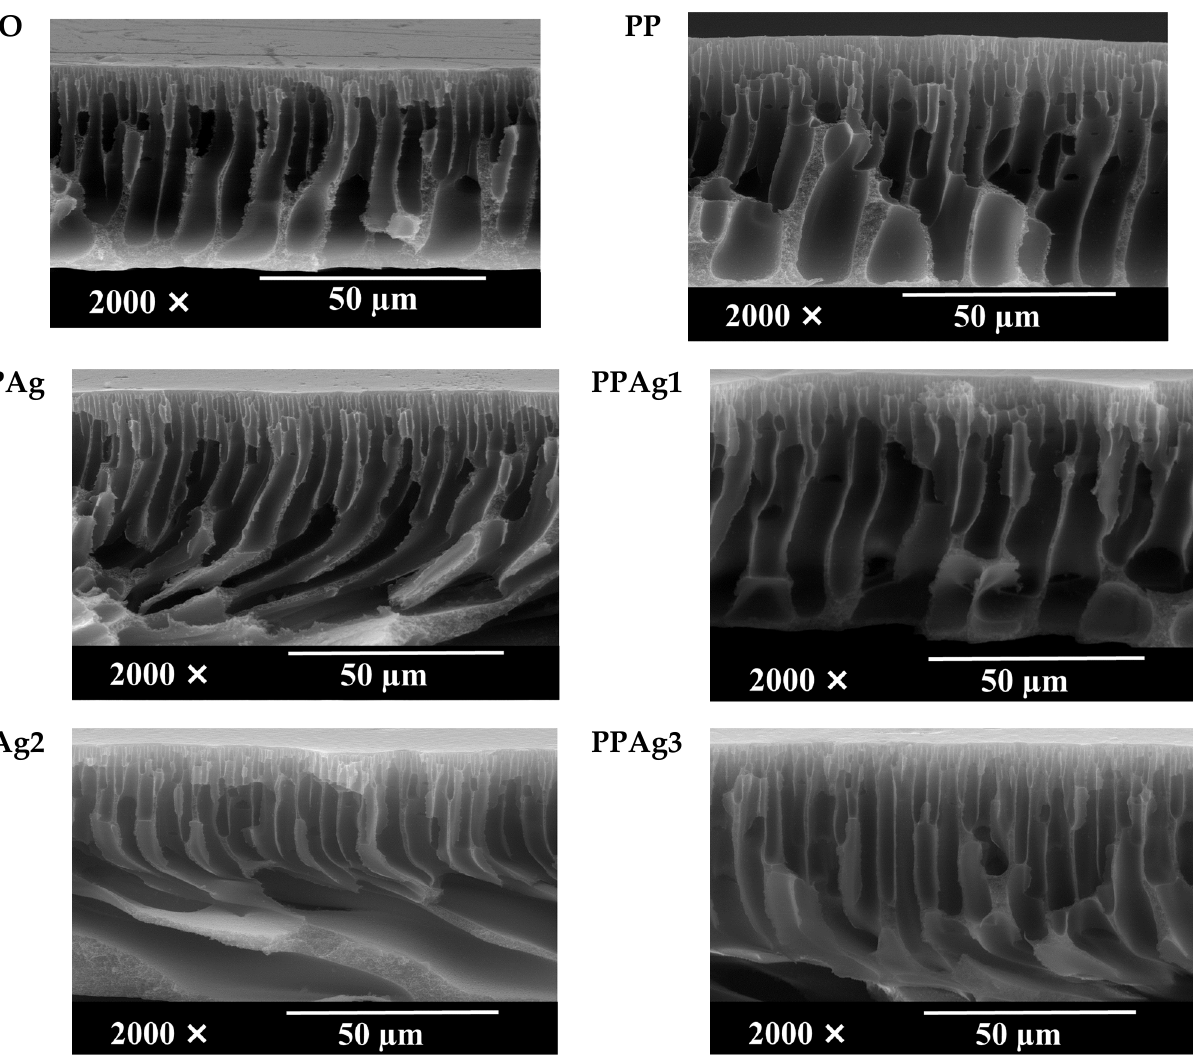
Figure 6. SEM images of membrane morphological structure.